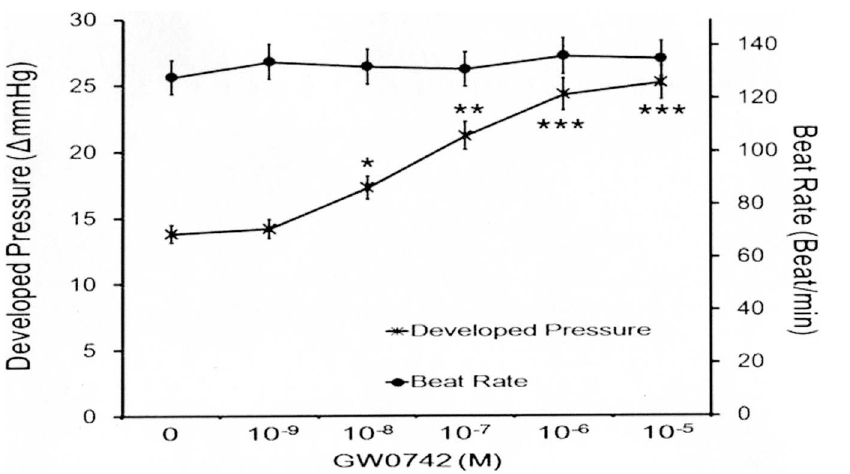
Figure 2. Dose-Related Action of GW0742 Regarding Cardiac Contractility or Heart Rate in Isolated Rat Hearts. Perfusion of GW0742 at various concentrations caused an increase in cardiac contractility but not heart rate. All values are presented as mean 6 SEM (n=8). * P , 0.05, ** P , 0.01 and *** P , 0.001 compared with the non-treated controls.